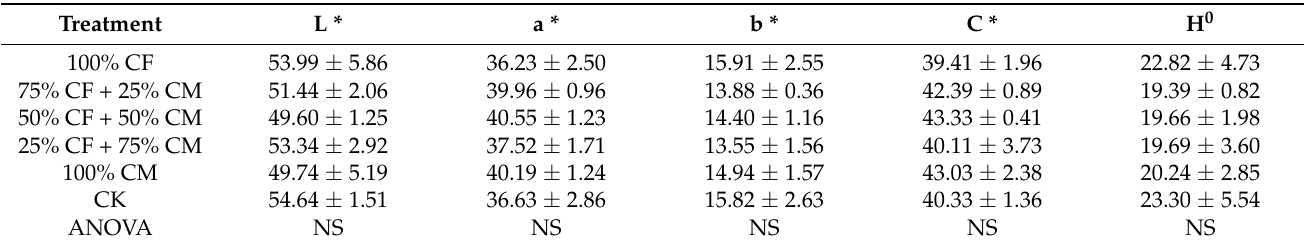
Table 3. Effect of different ratios of cow manure and chemical fertilizers on the colour of the sunny side of